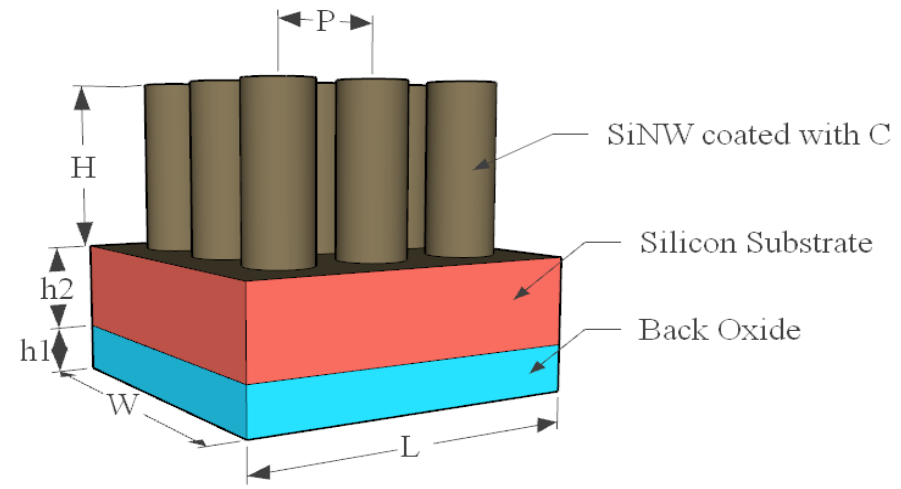
Figure 1. Schematic diagram of the proposed structure. The refractive index of back oxide is 1.4; however, the value for silicon is a function of the wavelength and follows the Aspnes and Studna model [25], and the refractive index of graphene follows the Phillip and Taft model [26]. On the other hand, the refractive in- dex of plasmonic NPs is summarized using Equation (6) in Table 1 [27]. Table 1. Plasmonic parameters used for the metallic nanoparticle.